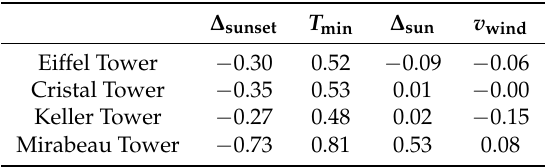
Table 4. Normalized correlation with the deformation ∆